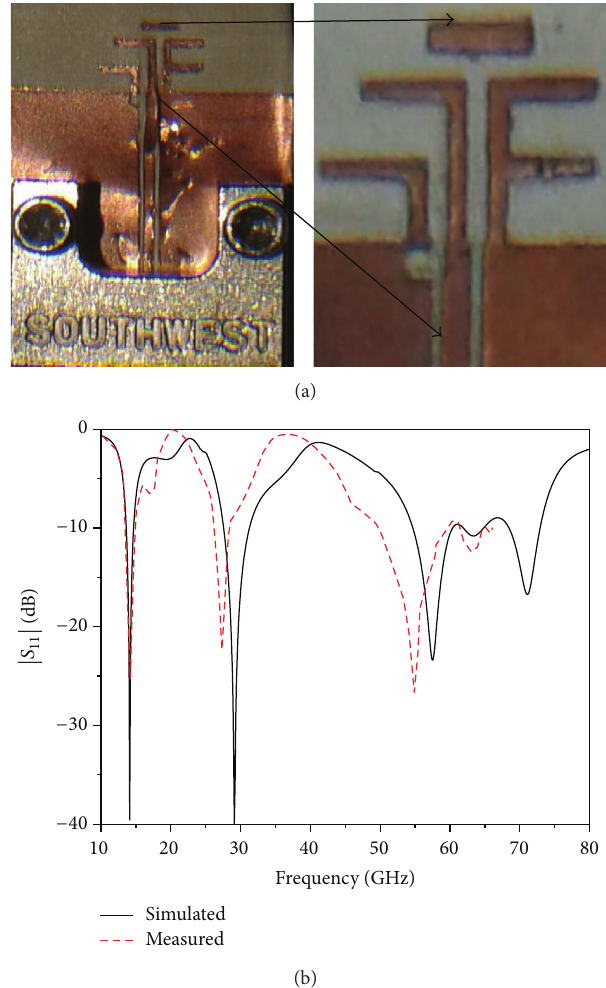
Figure 7: (a) Photo of fabricated antenna and (b) simulated and measured |𝑆 11 | characteristics of the